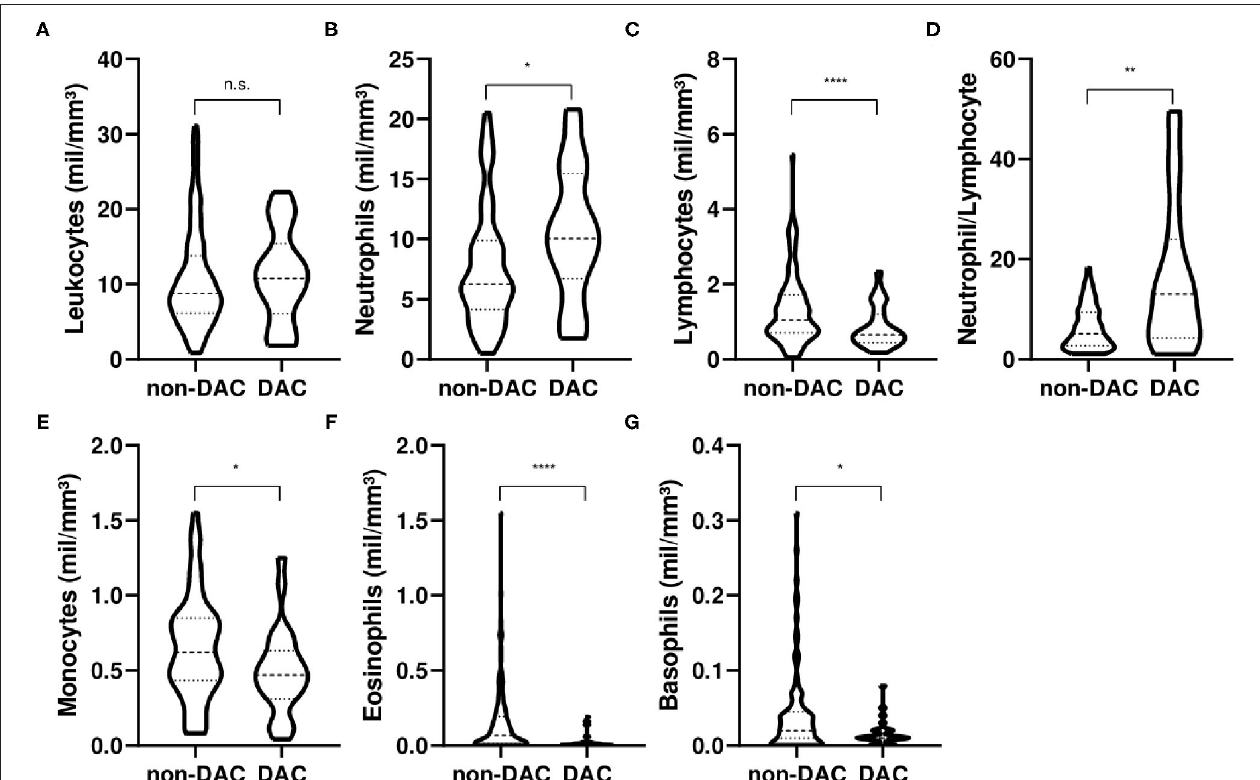
FIGURE 1 | Clinical features of patients with COVID-19. (A) Leukocyte counts, (B) Neutrophil counts, (C) Lymphocyte counts, (D) Neutrophil-to-lymphocyte ratio, (E) Monocyte counts, (F) Eosinophil counts, and (G) Basophil counts from the first day of hospitalization due to the SARS-CoV-2 infection. DAC, patients with self-reported daily alcohol consumption (DAC) and COVID-19; Non-DAC, patients without DAC and COVID-19. * p < 0.05, ** p < 0.01, **** p < 0.0001, n.s., non-statistically significant difference. Mann-Whitney test used for comparisons. Data collected between June 1, 2020 and December 1,